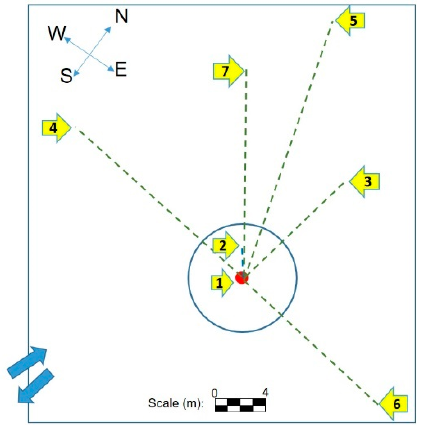
Figure 8. General schematic presentation of the distribution of evidence found after the explosion